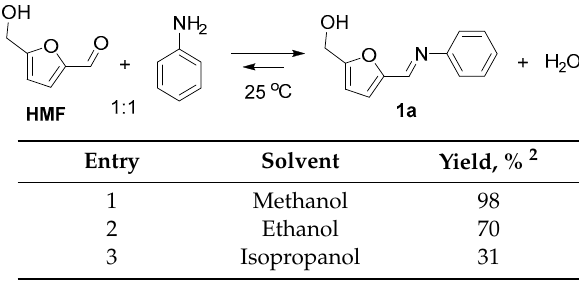
Table 1. Condensation of 5-hydroxymethylfurfural (HMF) with aniline 1 .